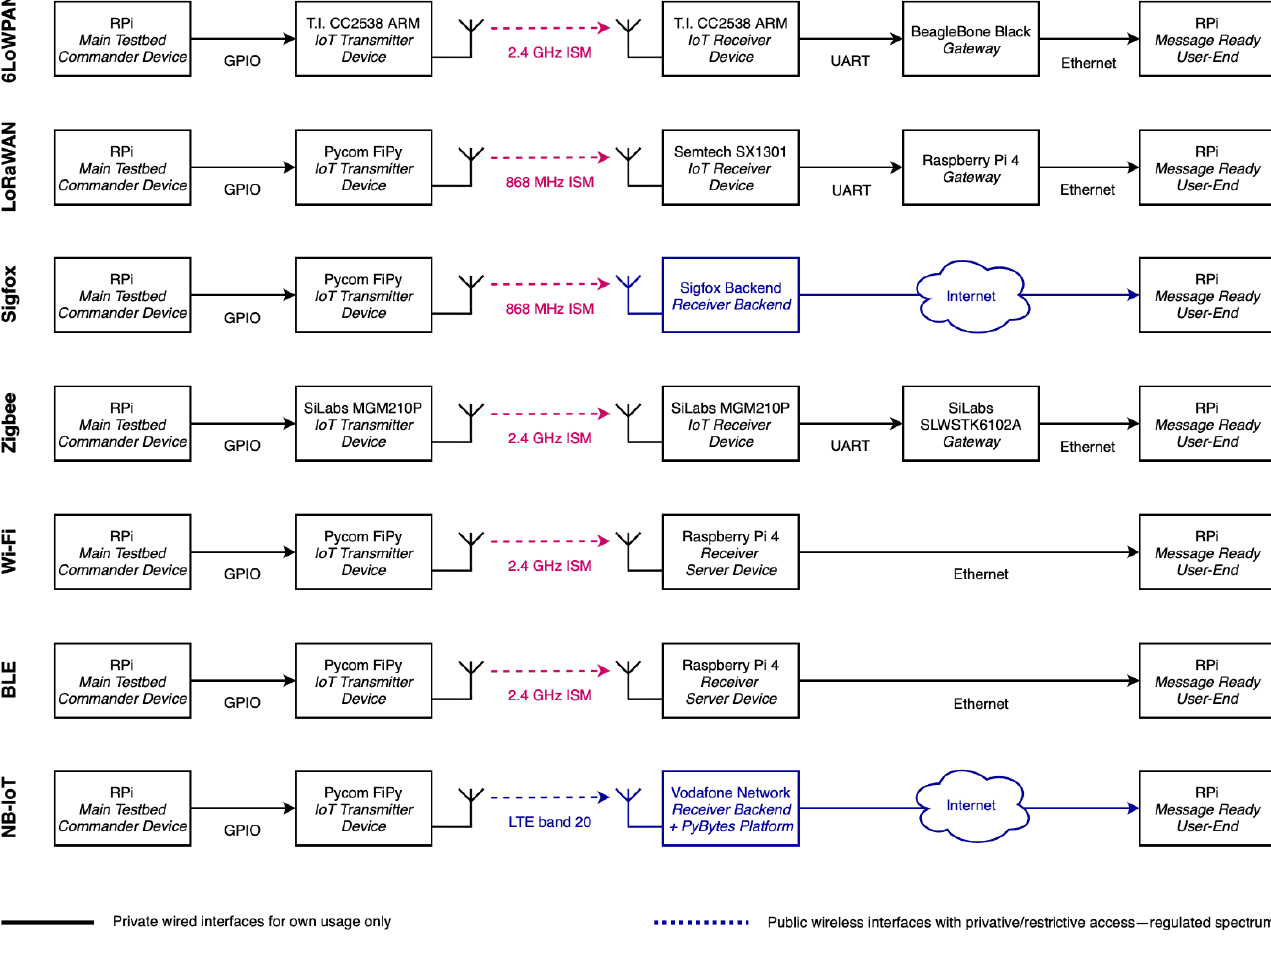
Figure A1. Detailed message paths for the wireless technologies characterised in this work, depicting the devices and interfaces used in each step. Note that other configurations—provided they comply with the standard—could be used, but these are the ones actually deployed in the laboratory for characterisation and Testbed validation. We also wanted to implement the most local approach possible in order to have more control over the message path.